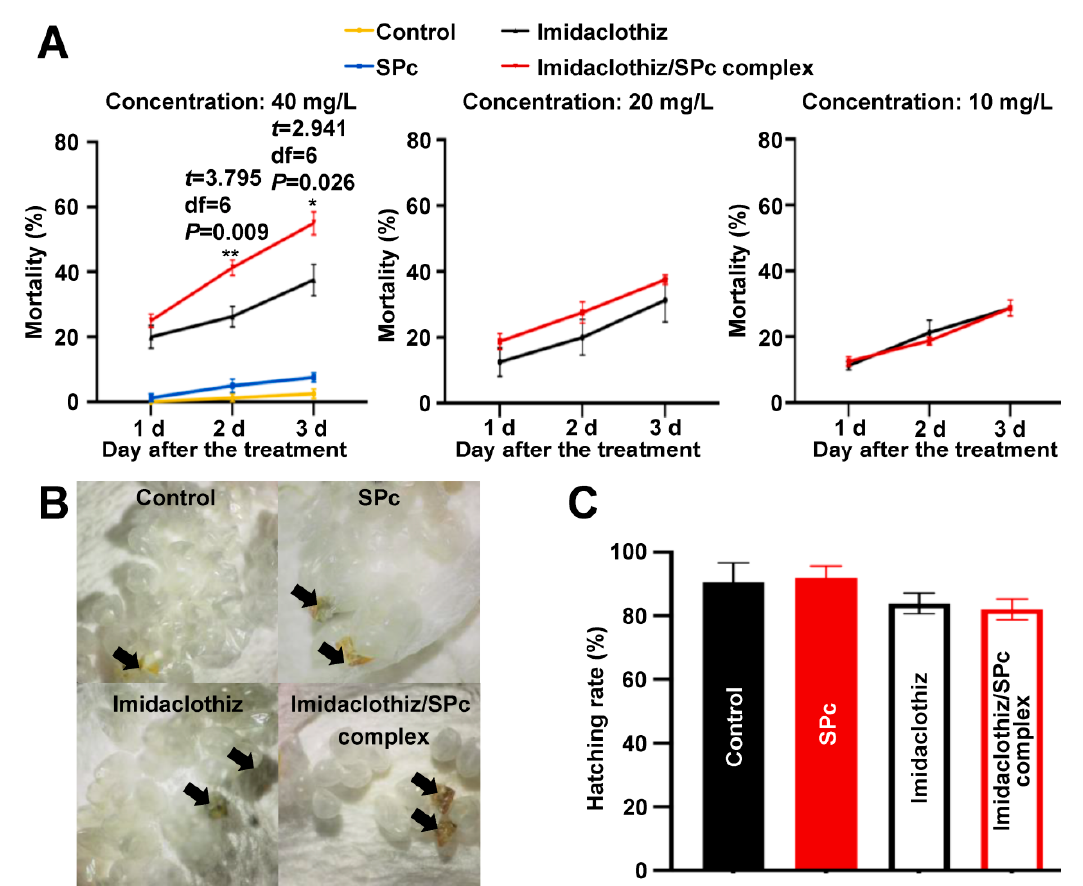
Figure 7. Potential negative effects of SPc-loaded imidaclothiz on lady beetle Harmonia axyridis . ( A ) Toxicity of SPc-loaded imidaclothiz against 1st instar larvae of lady beetles. The larvae were immersed in the formulations of imidaclothiz/SPc complex, imidaclothiz, SPc and ddH 2 O (control) for 10 s, and the mortality was recorded and calculated. Each treatment included approximately 20 larvae and was repeated 4 times. The “*” and “**” indicate significant differences according to the independent t test ( p < 0.05 and p < 0.01). ( B ) Photos of lady beetle eggs treated with various formulations. The eggs of lady beetles were immersed in the formulations of imidaclothiz/SPc complex at the mass ratio of 1:1 (imidaclothiz concentration: 40 mg/mL), imidaclothiz, SPc and ddH 2 O (control) for 10 s, and the photos were collected 3 d after the immersion. The arrows indicate the dead eggs. ( C ) Egg hatching rate of lady beetles. The hatching rate of above treated eggs was recorded and calculated 3 d after the immersion. Each treatment included approximately 30 eggs and was repeated 4